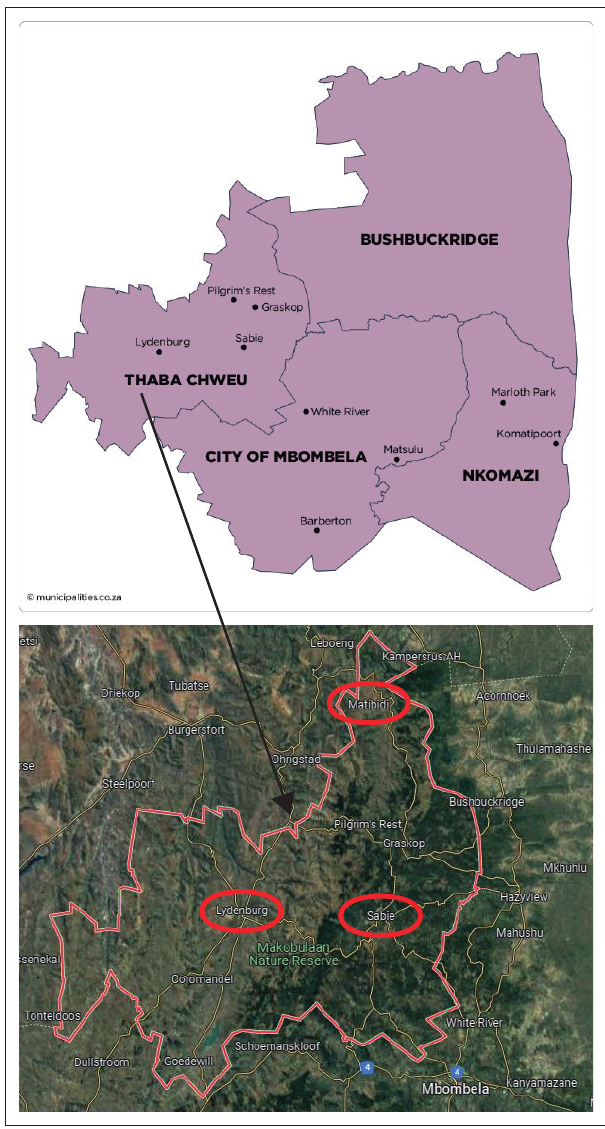
FIGURE 1: Ehlanzeni